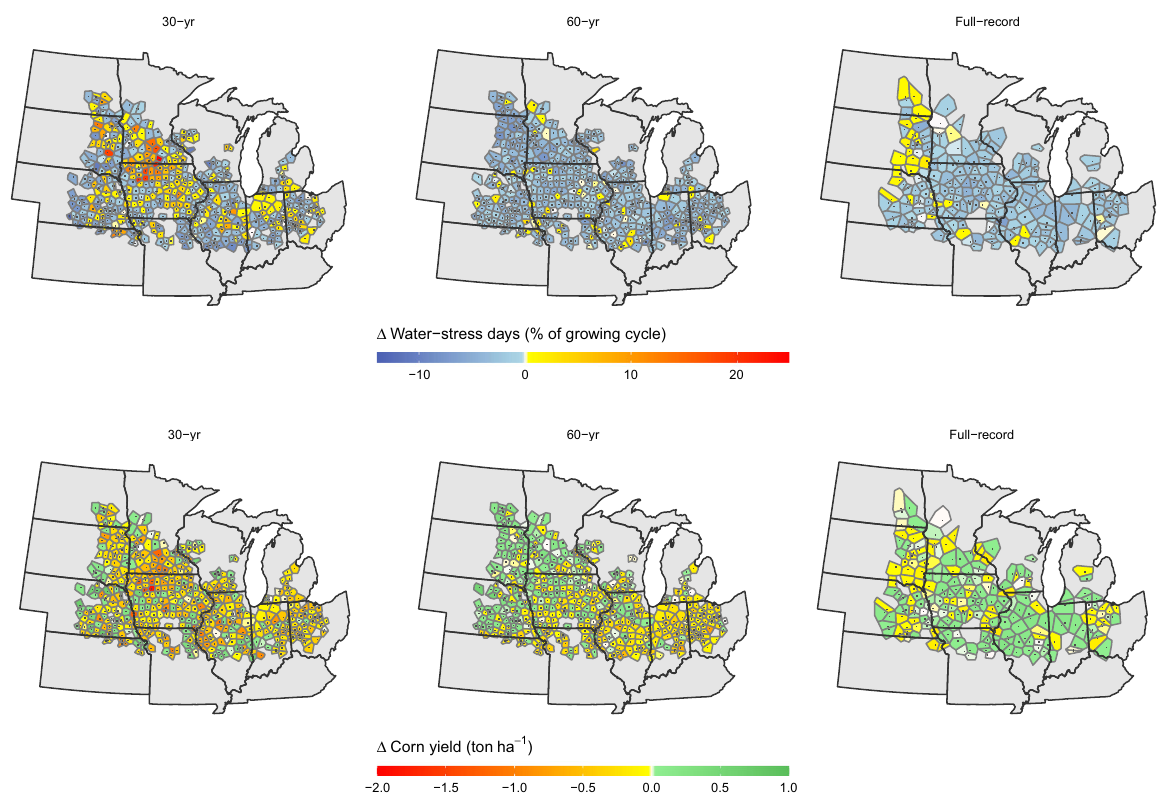
Fig. 5 Impacts of projected summer temperature and rainfall trends on corn water-stress days and yield as simulated by the SALUS model. Voronoi polygons indicate coverage of stations within major corn-producing Midwestern